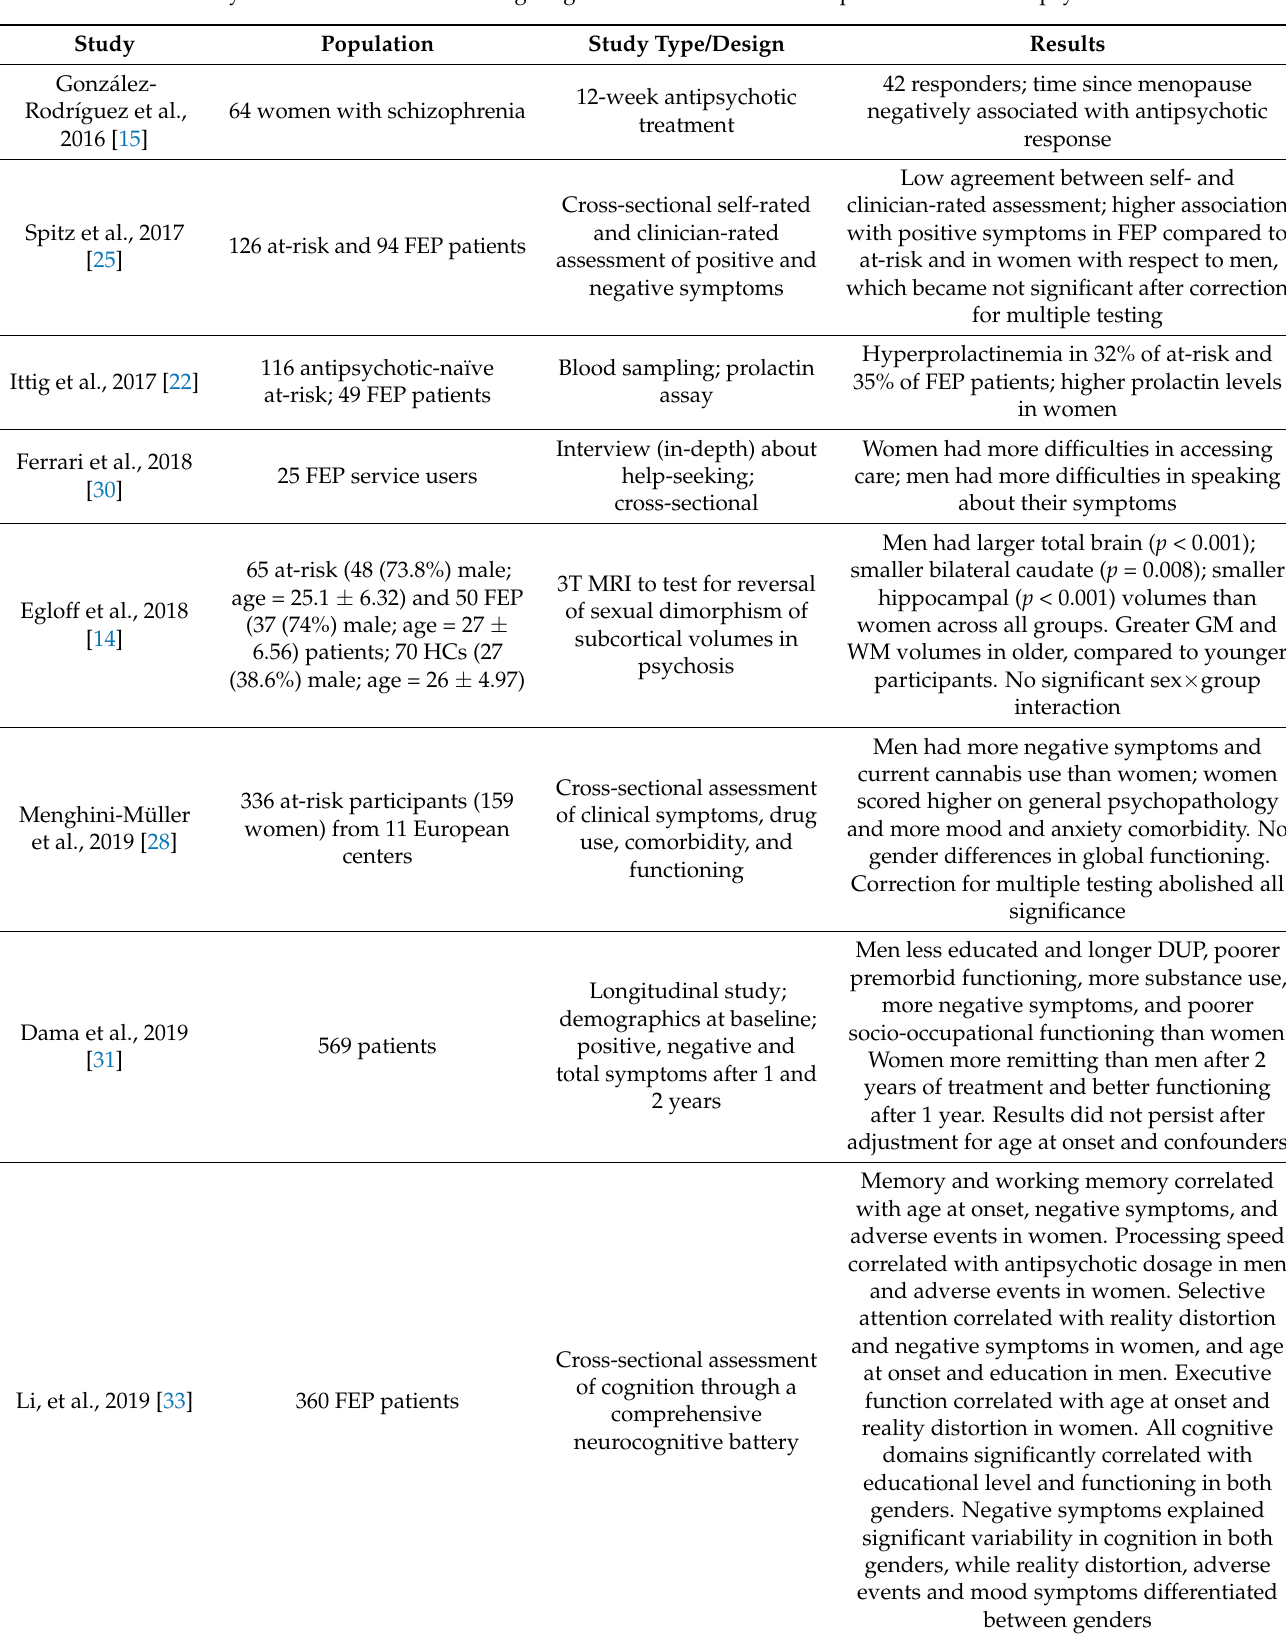
Table 1. Summary of included studies focusing on gender differences in schizophrenia and related psychotic